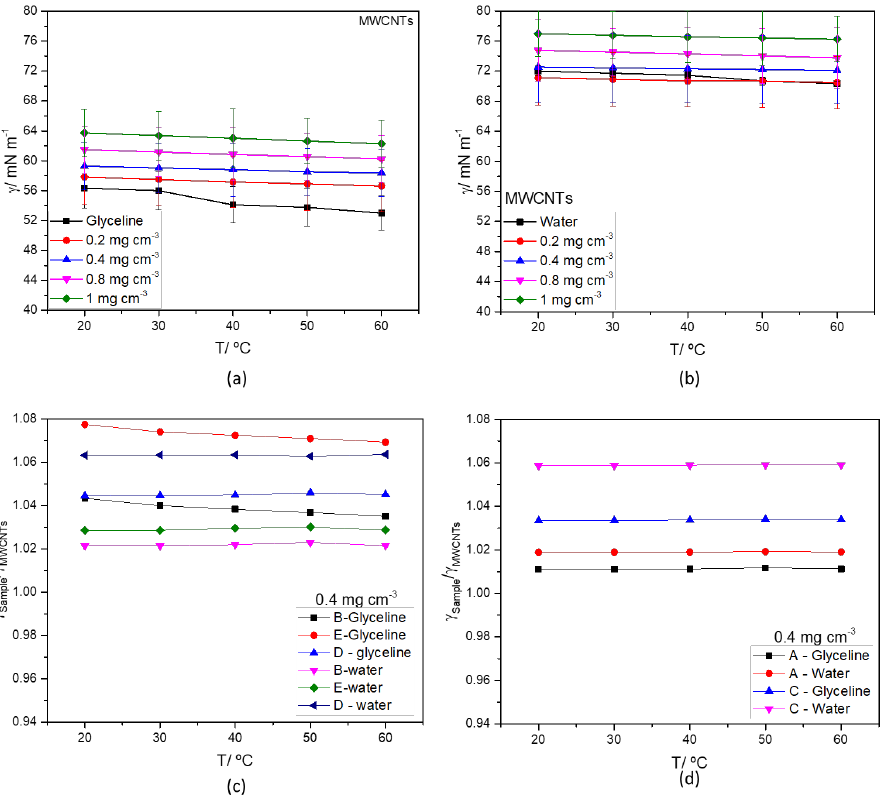
Figure 6. Surface tension of MWCNTs mixtures (0.2–1.0 mg cm −3 ) in glyceline ( a ), water ( b ) as a function of temperature, and surface tension ratio of AgMWCNTs (0.4 mg cm −3 ) Samples B, D and E ( c ) and A and C ( d ) as a function of temperature, in glyceline and water. Figure 6a,b show that both tested solvents display a decrease in surface tension with